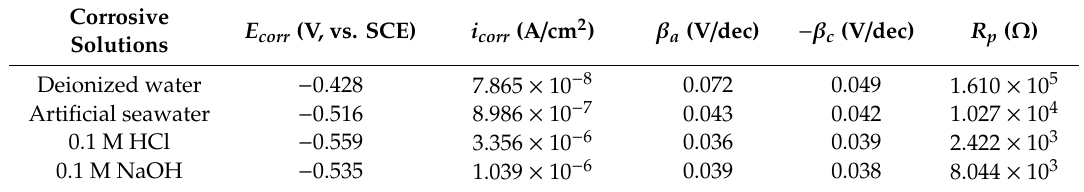
Table 1. Corrosion parameters of NiCrAlY coating from potentiodynamic polarization curves.